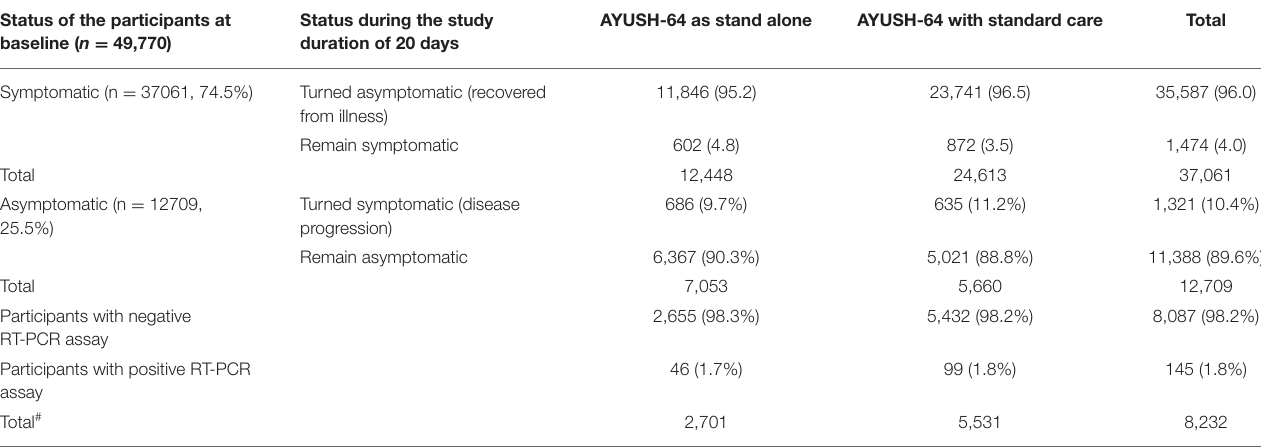
TABLE 2 | Status of RT-PCR/RAT assay and clinical recovery of participants during the study. Status of the participants at baseline ( n = 49,770)